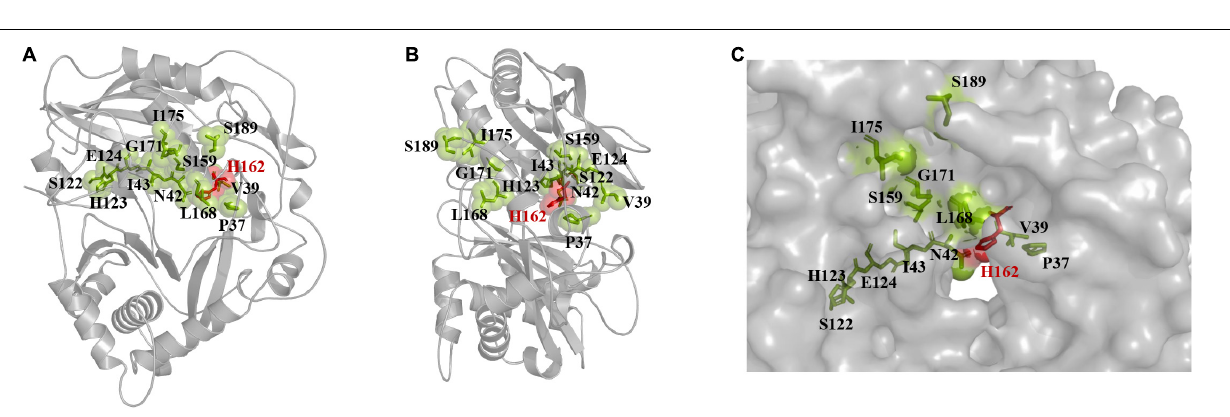
Frontiers in Microbiology |